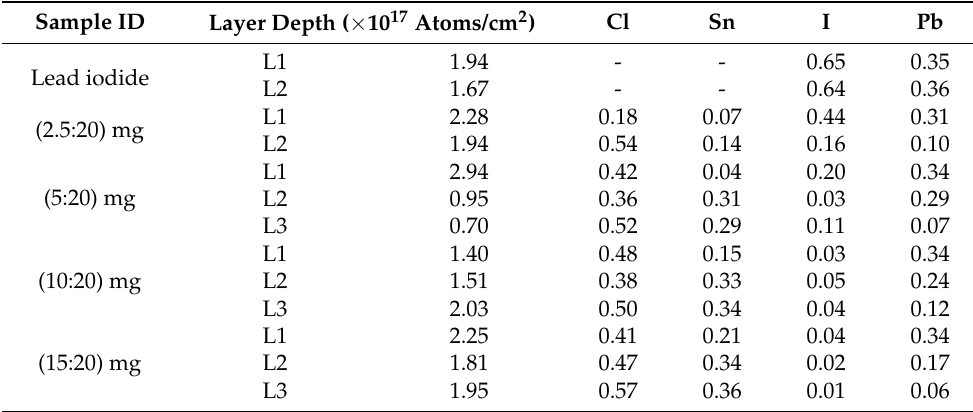
Figure 2. ( a ) The experimental RBS spectra of PbI 2 and mixed SnCl 2 -PbI 2 compound thin films, and ( b ) the compositional ratios of Sn/(Sn + Pb) and Cl/(Cl + I) in the precursor films. Table 1. Stoichiometry obtained from the simulated RBS